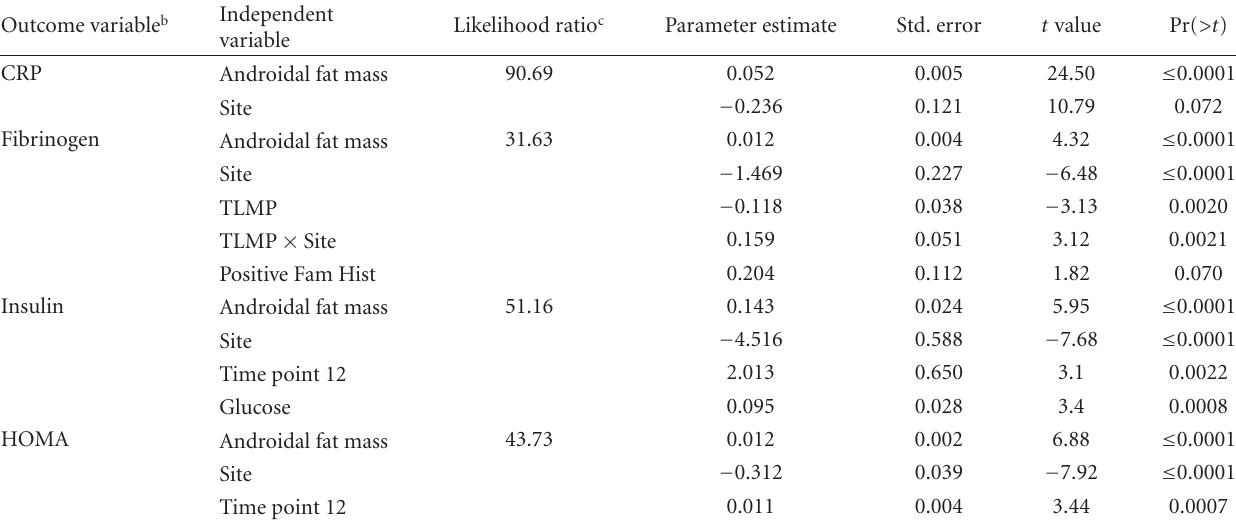
Table 3: Multivariate linear regression: covariates associated with each outcome variable a assessed from baseline through 12 months. Outcome variable